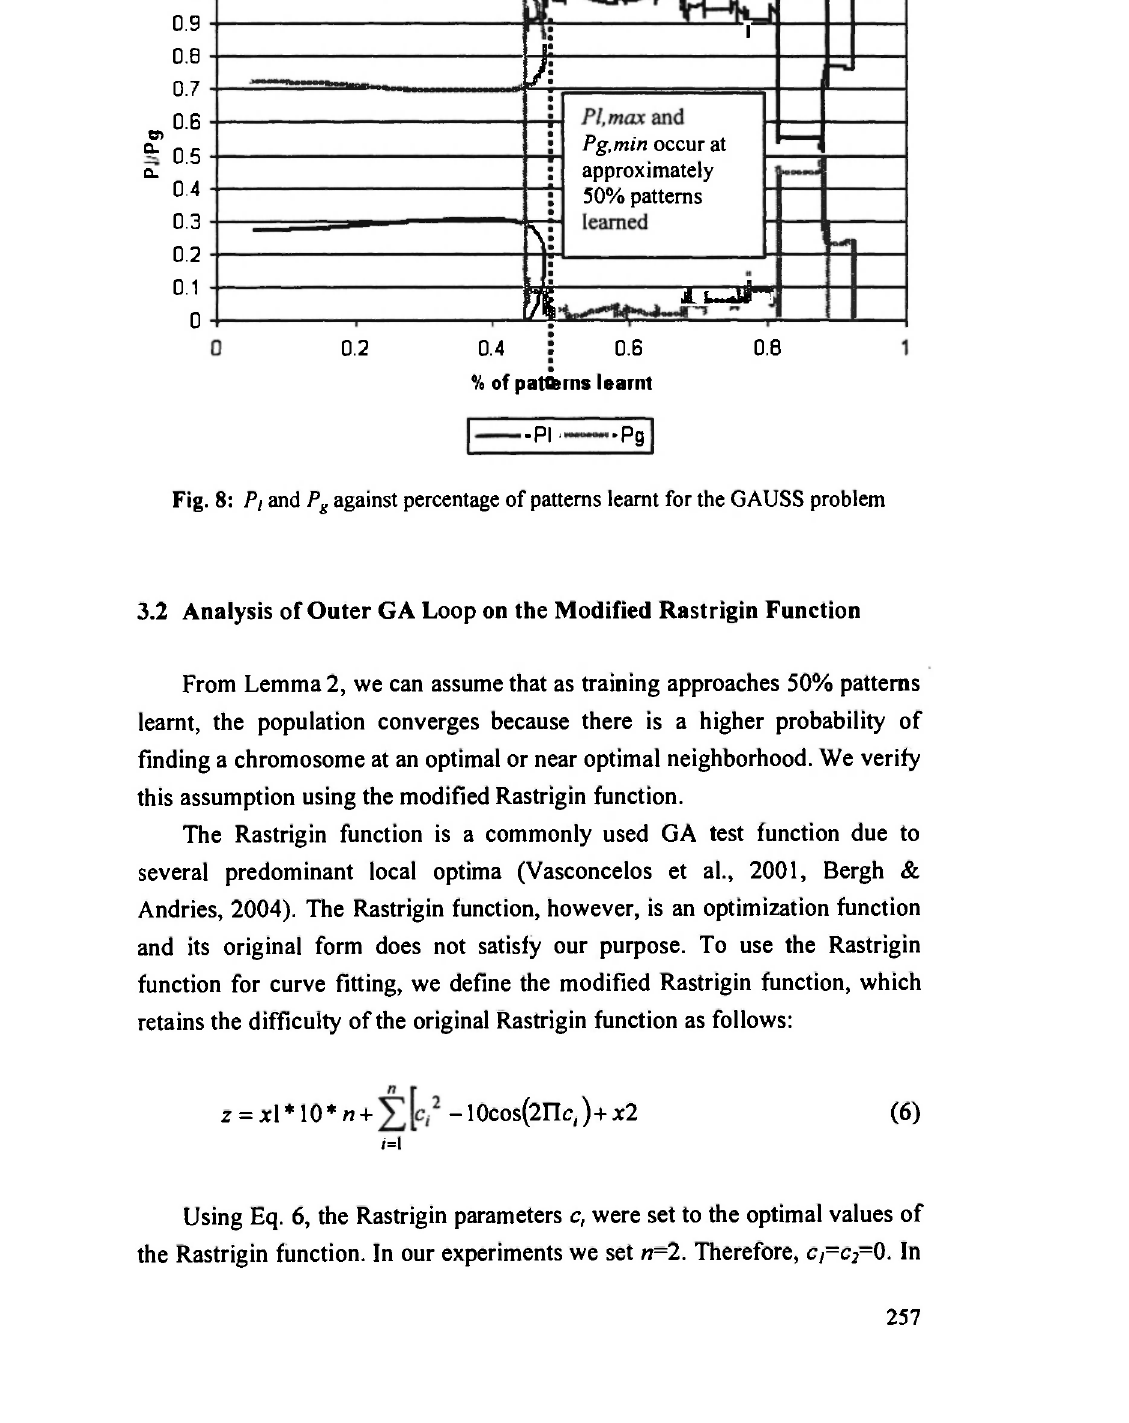
Fig. 8: Pi and P g against percentage of patterns learnt for the GAUSS